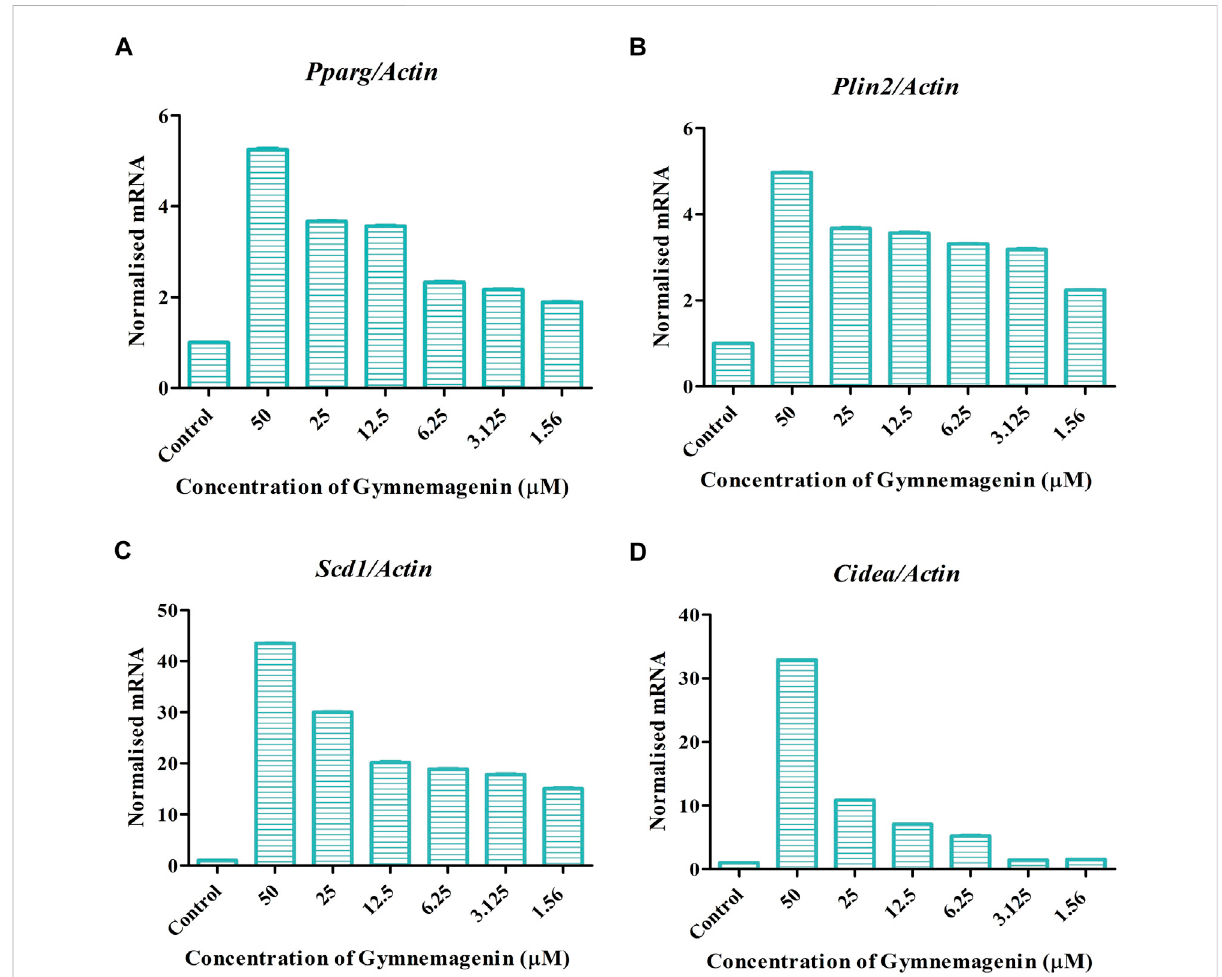
FIGURE 4 Effect of gymnemagenin on genes actively involved in adipogenesis expressed in 3T3L1 adipocytes. (A) Gymnemagenin increased the expression of Pparg in treated cells more than in control cells. (B) Gymnemagenin escalated the expression of Plin2 . (C) Gymnemagenin increased the expression of Scd1 . (D) Gymnemagenin increased the expression of Cidea . Data represent the mean ± SE. n = 3 per